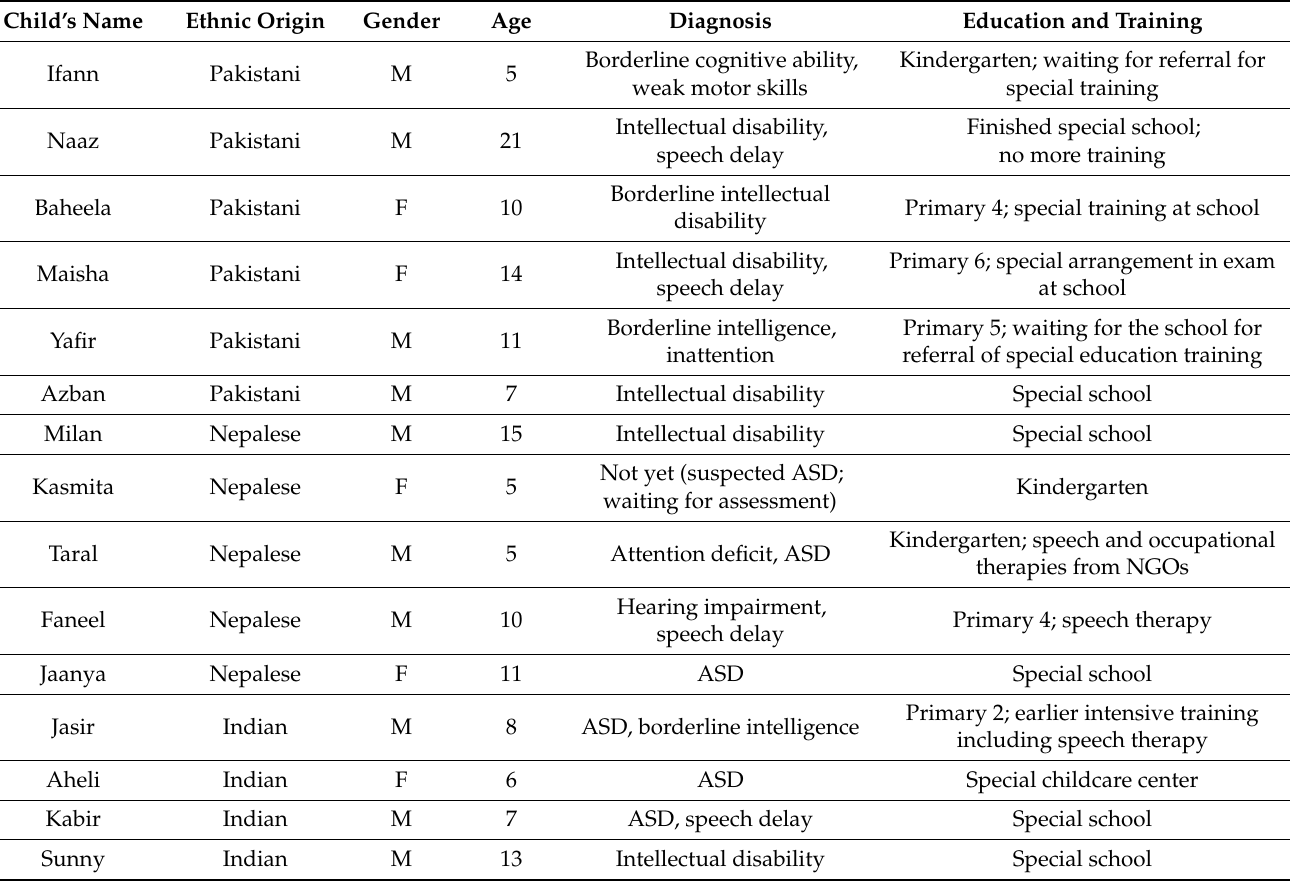
Table 1. Participant children’s demographic